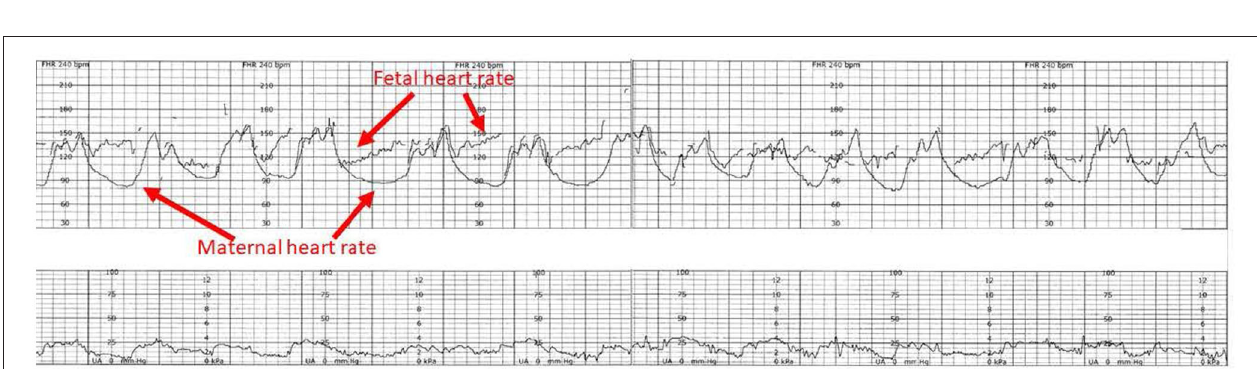
FIGURE 10 | arterial ischemic stroke and the appearance of the “conversion pattern.” Notice the initially normal tracing (B1) followed by the sudden appearance of a prolonged deceleration whose recovery dramatically overshoots the previous baseline heart rate of 150 bpm. The pattern evolves through several decelerations to a stable baseline with persistently absent variability and absent decelerations permitting the diagnosis of fetal neurological injury (B2) . Scaling − 30 bpm/cm—vertical, 3 cm/min—horizontal—each panel is 16min wide.